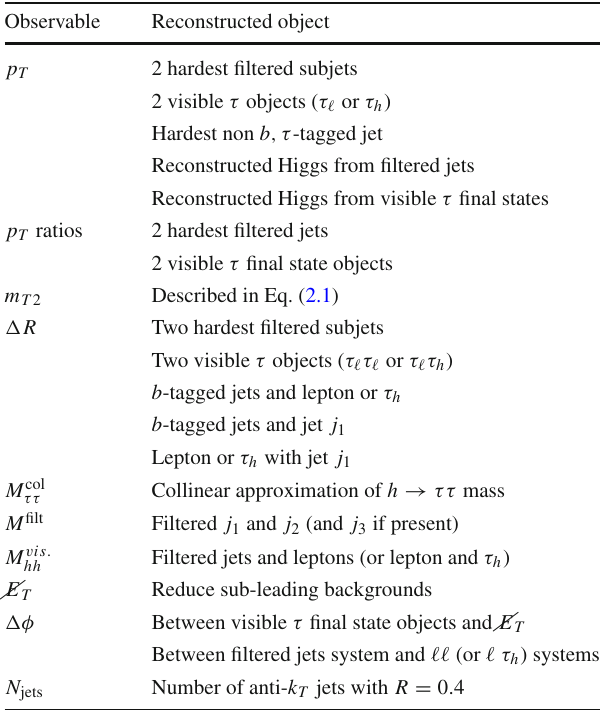
Table 4 Observables included to the boosted decision tree for the jet- substructure analysis of pp → hhj , Sect. 2.4